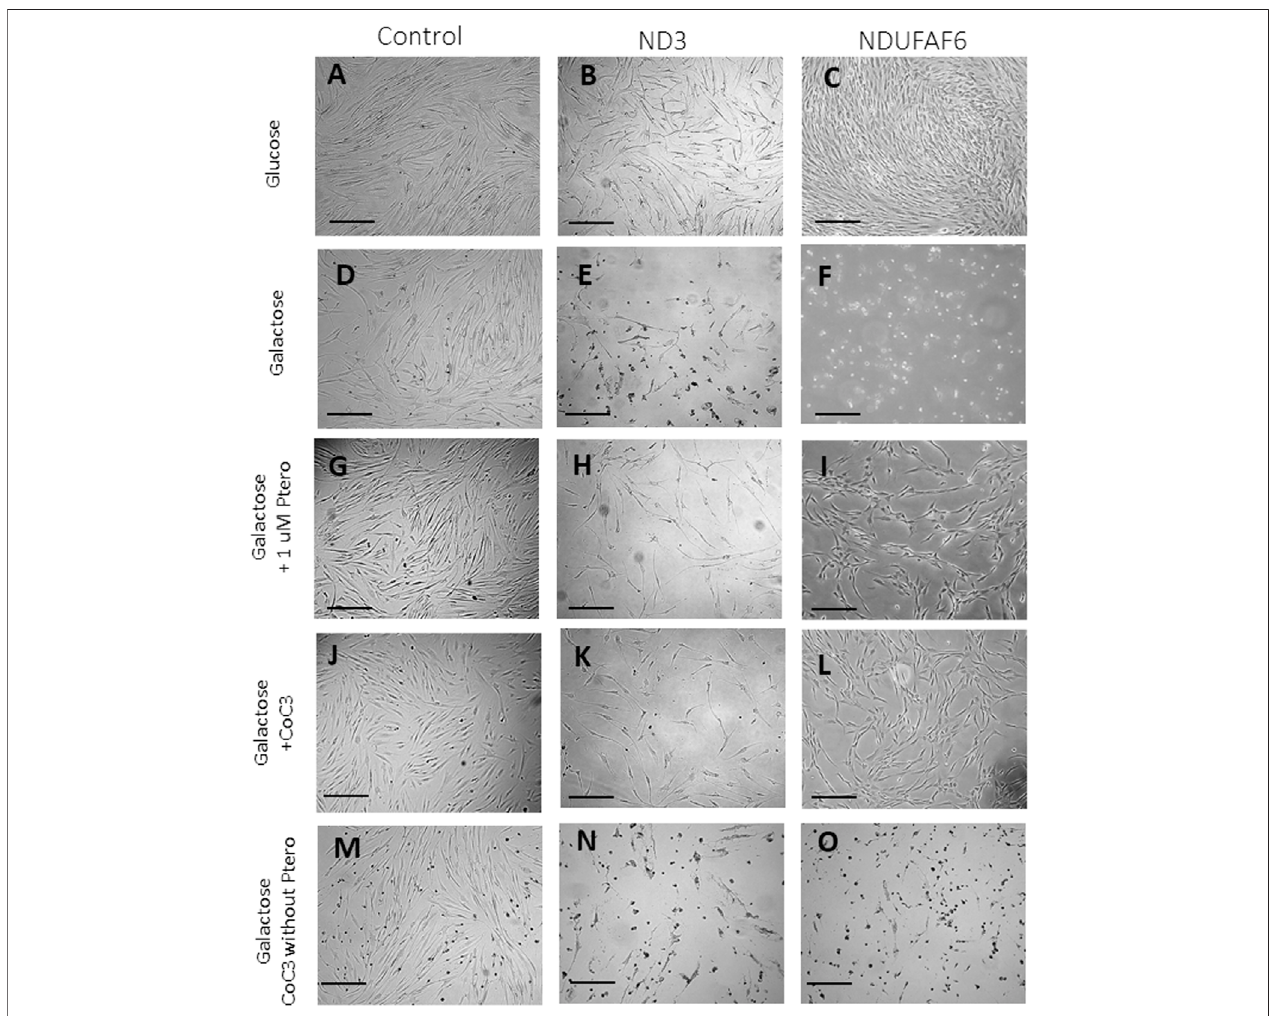
FIGURE 1 | Screening of compounds in galactose medium. Cells were initially seeded in DMEM high glucose. After 3 days, glucose medium was changed to galactose. Images were acquired right after changing the medium and after 72 h of incubation. In optimal conditions control and both mutant cell lines present a similar proliferation rate (A – C) . Control cells almost do not alter their growth rate (D) but mutant ND3 and NDUFAF6 cells are unable to survive (E and F) . Pterostilbene (1 μ M) treatment does not affect control cells (J) but promotes the survival of mutant ND3 and NDUFAF6 cells in galactose medium (H and I) . In addition, cocktail CoC3 (1 μ M Pterostilbene, 5 μ M nicotinamide, 1 μ M ribo fl avin, 1 μ M thiamine, 1 μ M biotin, 5 μ M lipoic acid and 1 μ M L -carnitine) signi fi cantly improves pterostilbene ’ s positive effects (J – L) . CoC3 without ptersotilbene was also examined, but no favorable effect could be observed on mutant fi broblast (N and O) , suggestingthat pterostilbene is necessaryfor the positive effectof CoC3. Thequanti fi cation of cellular proliferation is shown in Supplementary Figure S4 . Scale bar = 40 μ m.